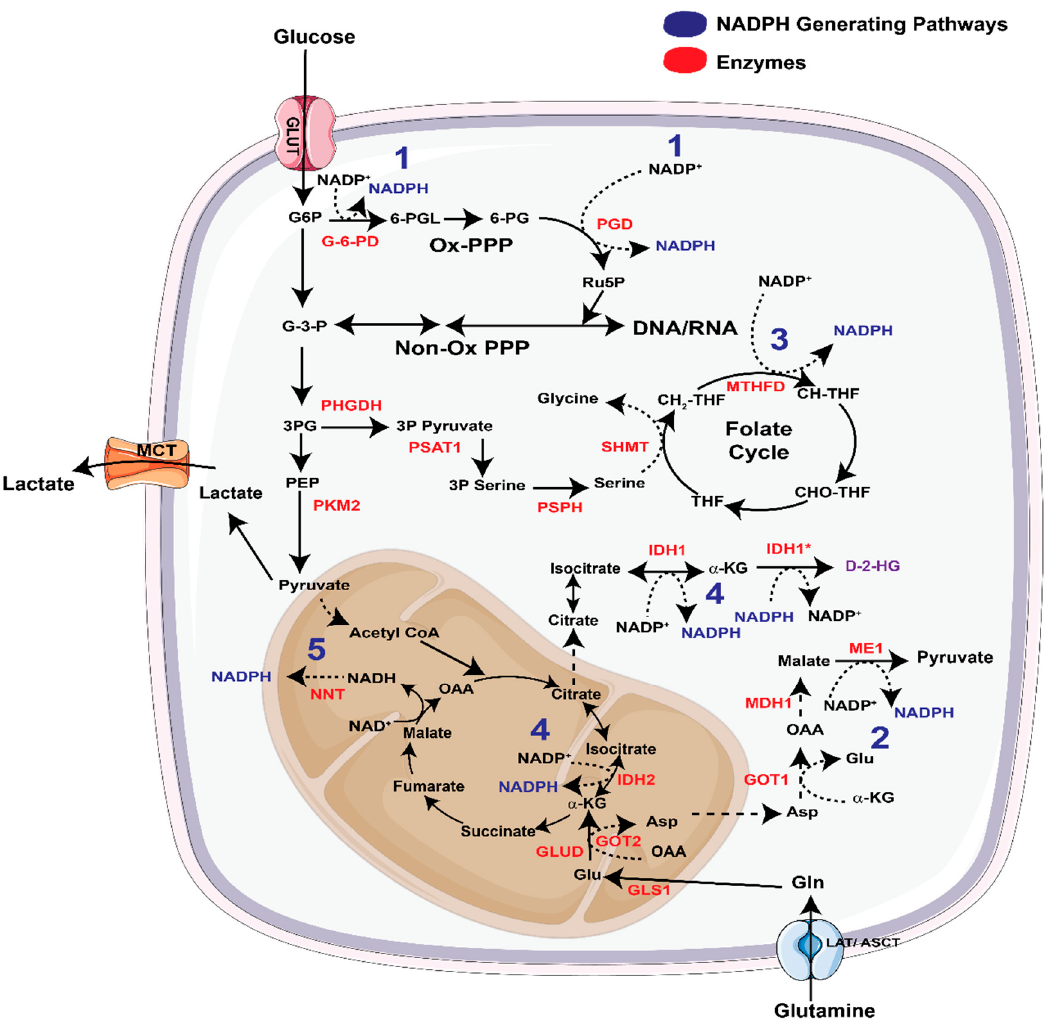
Figure 4. Altered metabolism as the source of nadph biosynthesis. The principal metabolic pathways that generate NADPH are numbered in blue with key enzymes shown in red. These include (1) the pentose phosphate pathway (PPP) in which conversion of Glucose-6-phosphate (G6P) to 6-phosphogluconolactone (6-PGL) and 6-phosphogluconate (6-PG) to ribulose-phosphate (Ru5P) generates 2 NADPH molecules. (2) Another mechanism of NADPH production is via the conversion of malate to pyruvate by malic enzyme 1. (3) The third reaction mediating NADPH production is the methylenetetrahydrofolate